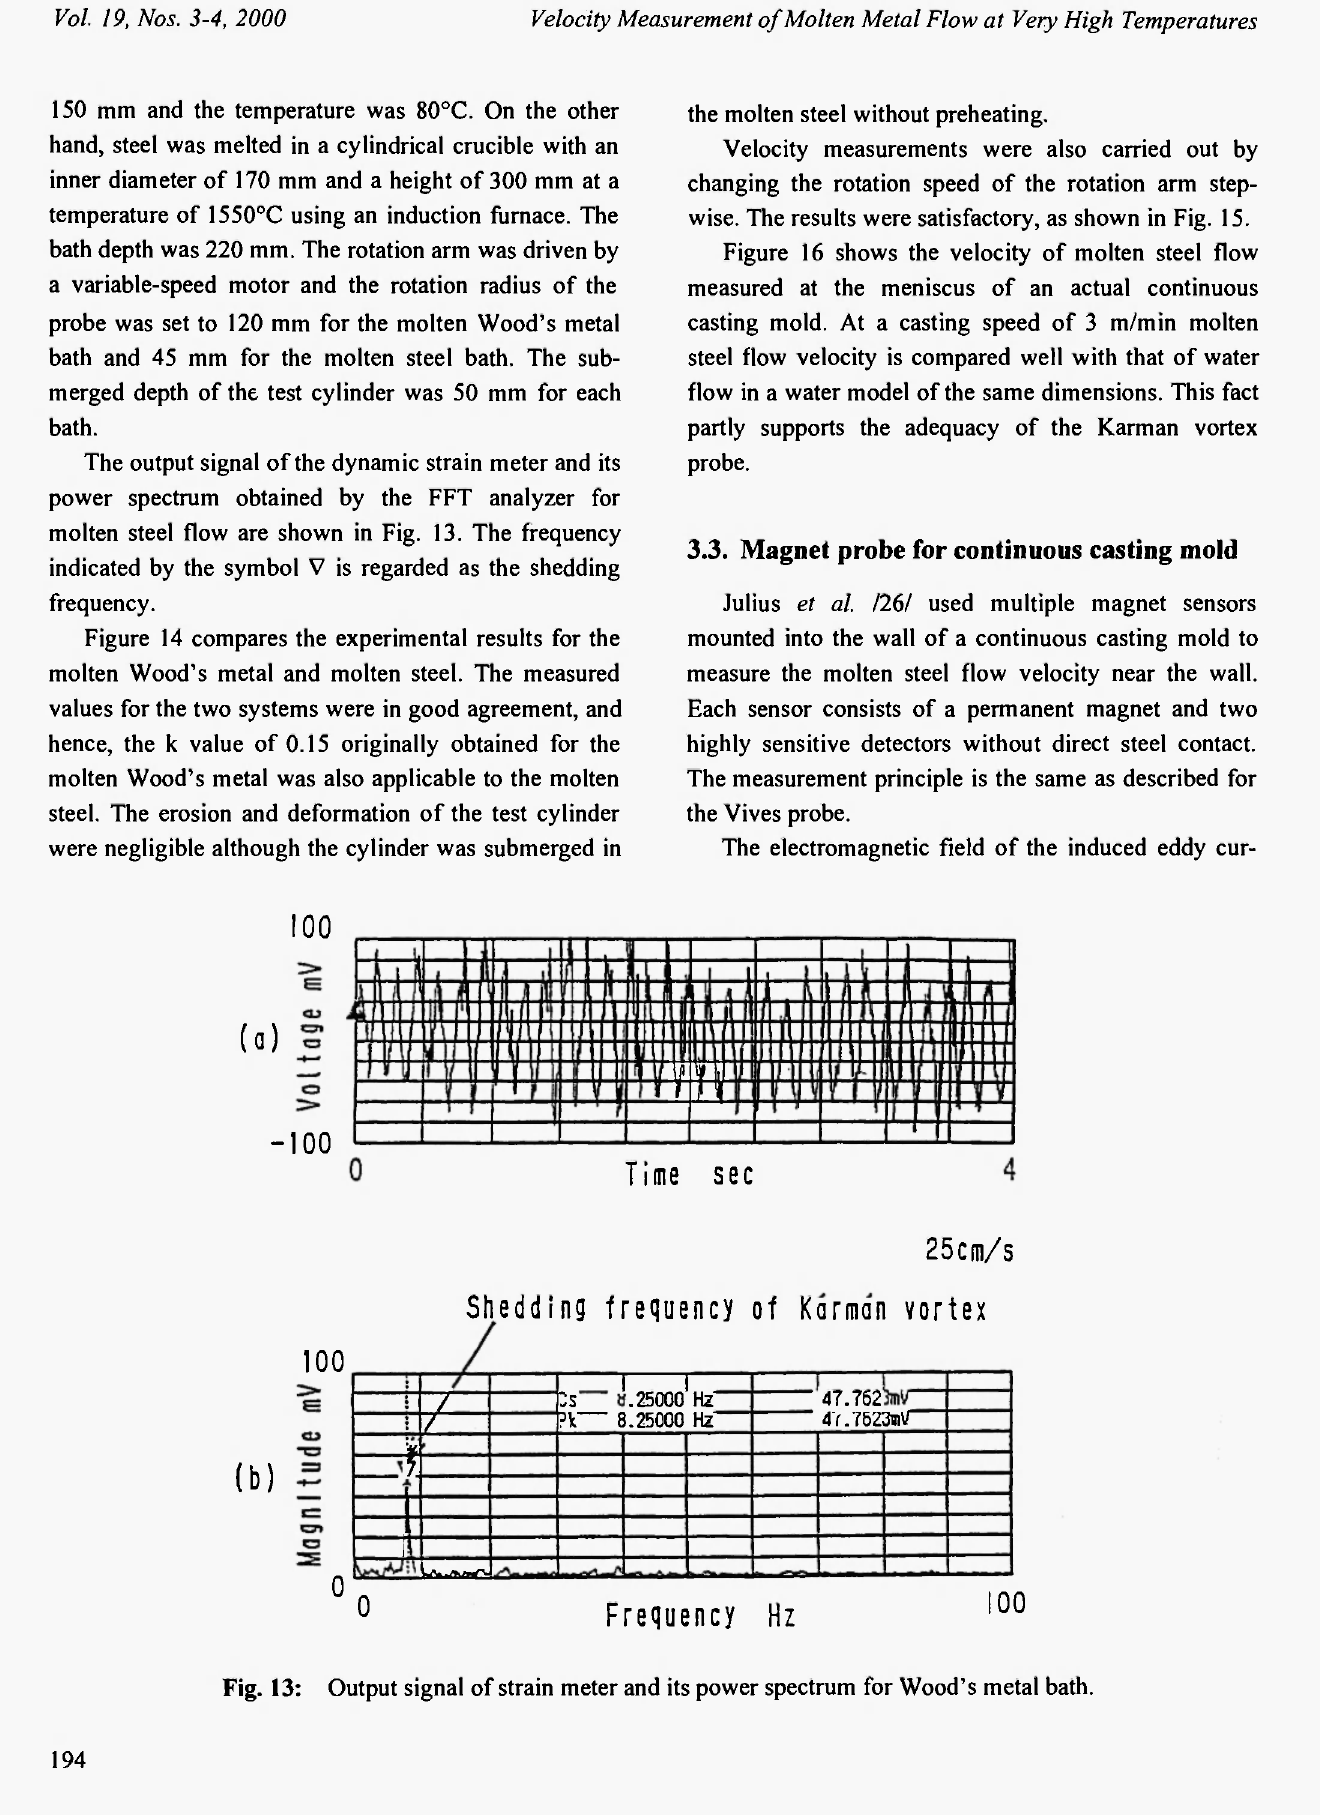
Fig. 13: Output signal of strain meter and its power spectrum for Wood's metal